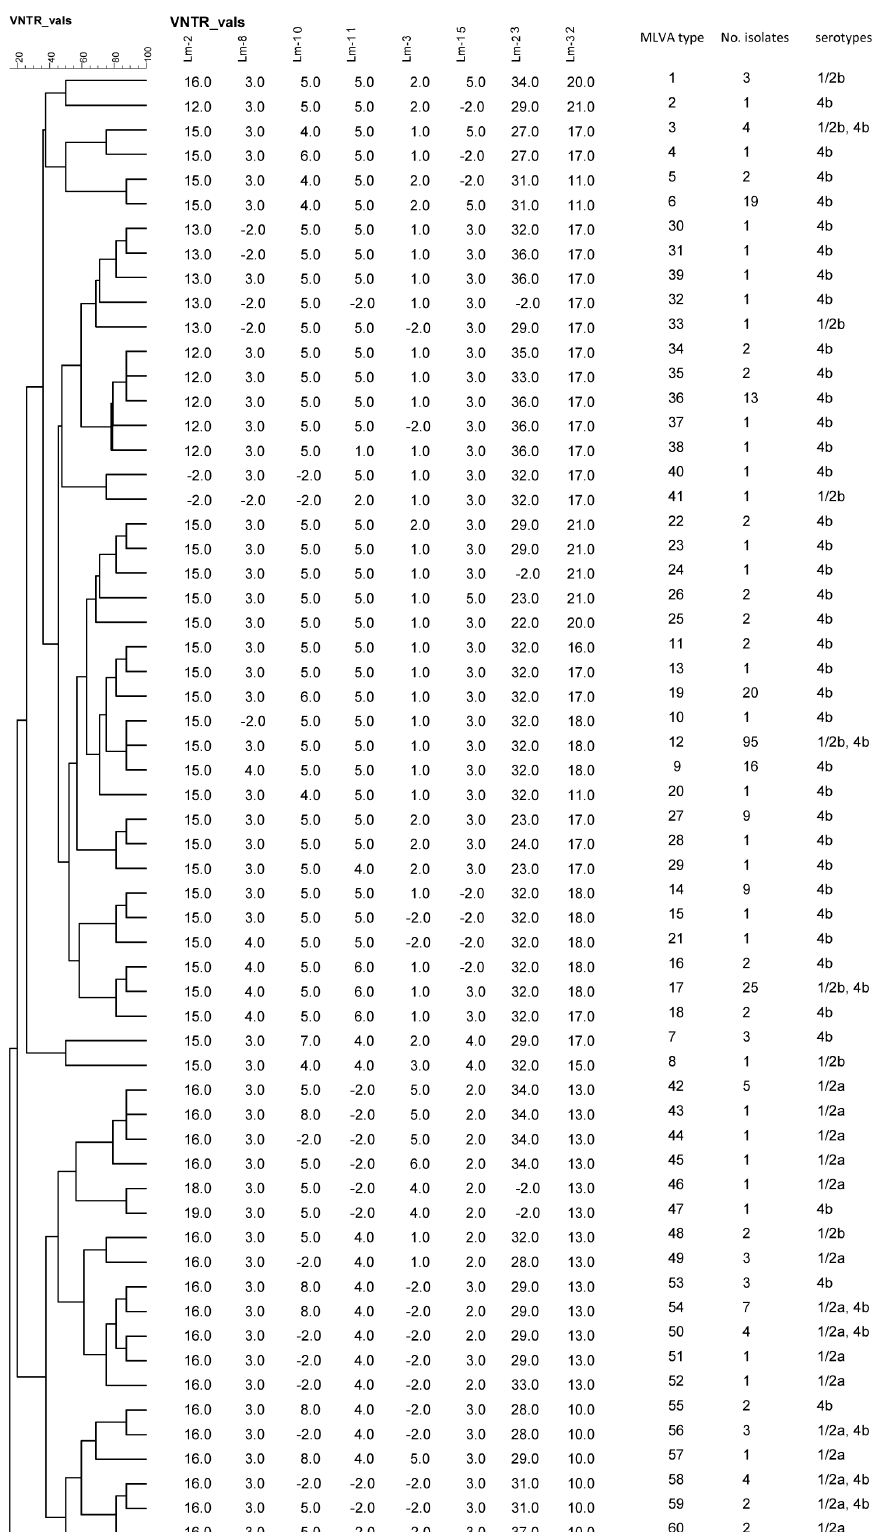
Figure 1. Categorical tree of MLVA types based on differences in VNTR copy number, and the numbers of isolates of each type and the serotypes represented in them. BioNumerics assigns a value of 2 2 to loci yielding no product.